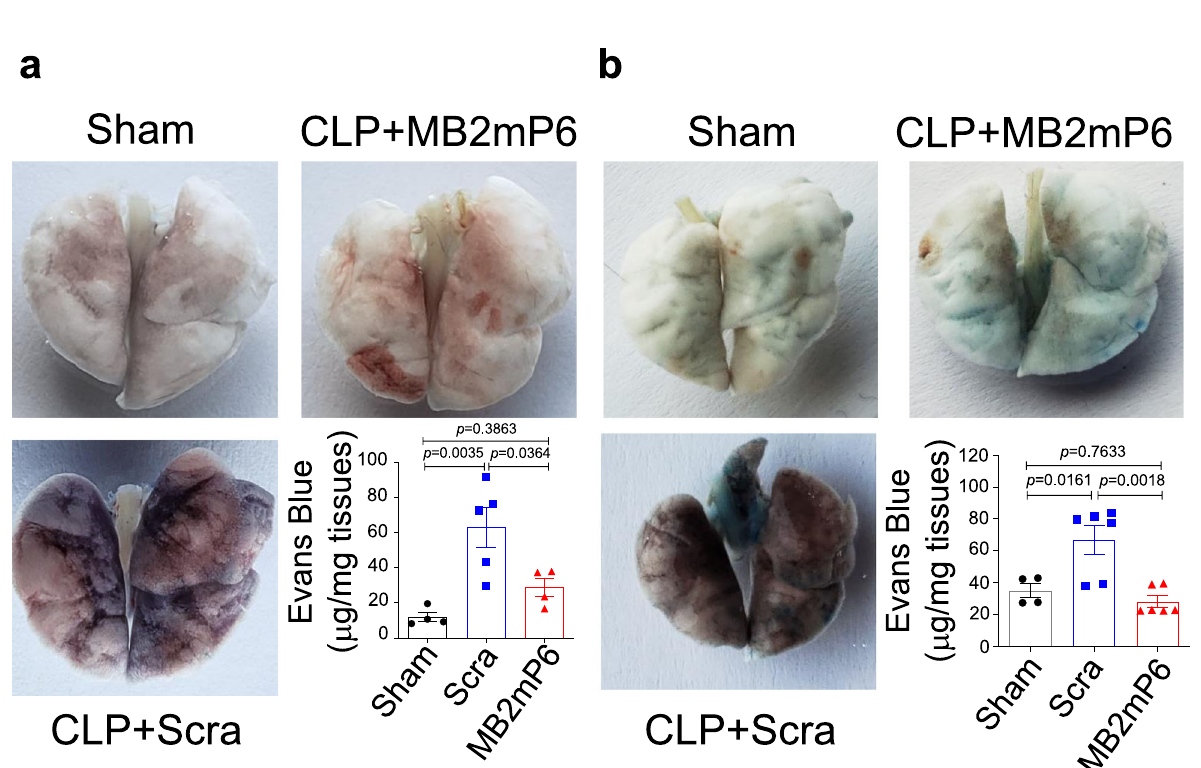
Fig. 6 MB2mP6 inhibits CLP-induced lung vascular leakage induced by CLP sepsis. a Representative images of septic mouse lungs 24 h after CLP. The mice were treated with scrambled peptide (Scra) or MB2mP6 immediately after CLP onset. At 23.5 h after CLP, the mice were i.v. injected with Evans blue albumin (EBA; 1%, 25 mg kg − 1 body weight). After 30 min, the mouse lungs were harvested, and the Evans blue was extracted by incubating with formamide at 65 o C for 18 h. The EBA contents in the lung tissues were calculated using a standard EBA curve detected at 620 nm absorbance with 740 nm reference (sham, n = 4; control, n = 5; MB2mP6, n = 4, independent animals). b , Representative images of septic mouse lungs 24 h after CLP treated with Scrambled peptide or MB2mP6 6 h after CLP onset. The Evans blue contents in septic mouse lung 24 h after CLP were analyzed as in ( a ) (sham, n = 4; control, n = 6; MB2mP6, n = 6, independent animals). All data are shown as mean ± SEM. Data were analyzed by one-way ANOVA with Tukey ’ s multiple comparisons